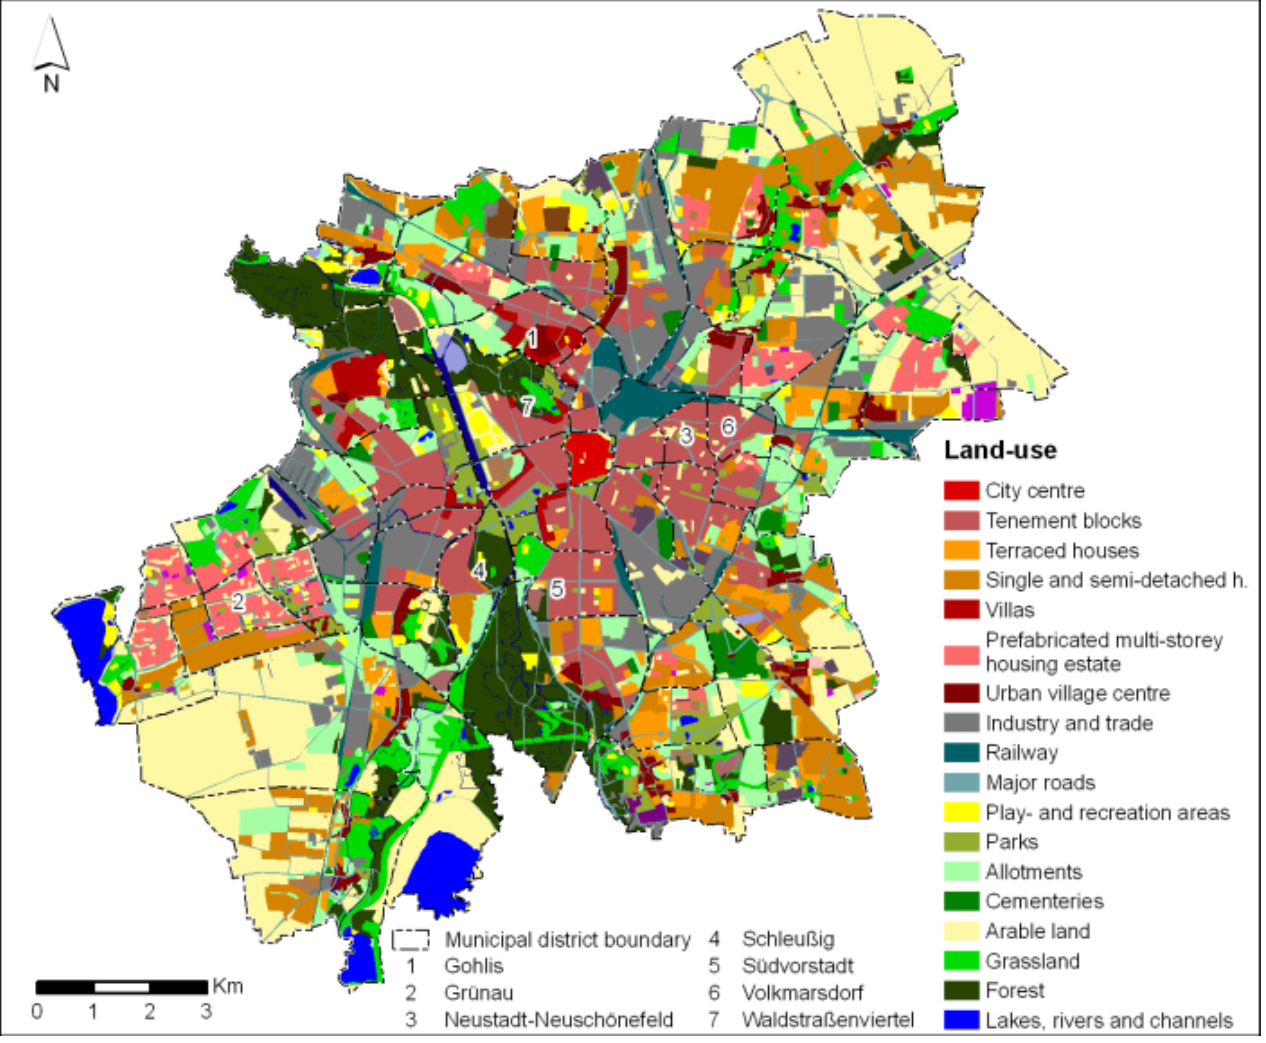
Fig. 1. Land-use classification of the study area of Leipzig, Germany, based on a map published in Haase and Nuissl